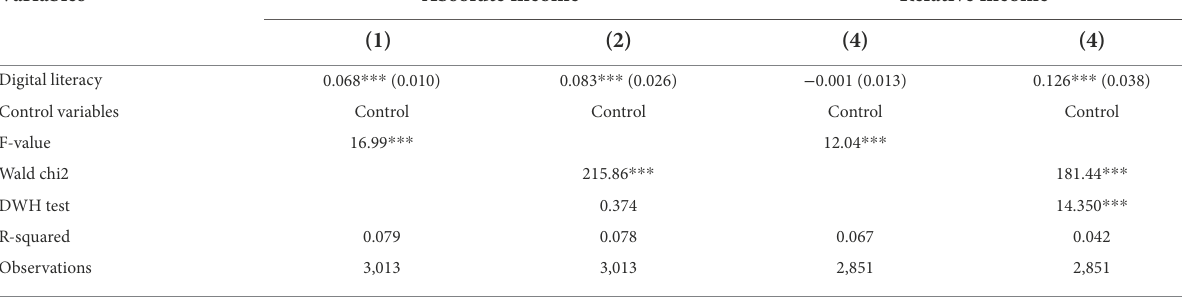
TABLE 6 Estimates of the impact of digital literacy on absolute and relative